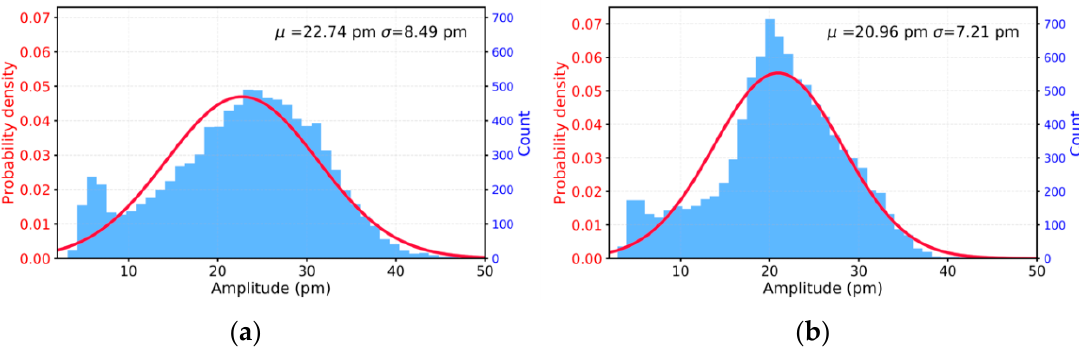
Figure 6. Piezoelectric amplitude histograms of ZnO NW growth on ( a ) ZnO (ALD)/ITO/Si and ( b ) as-printed (not sintered) ZnO seed layer/ITO/PET substrates. The red curve is the Gaussian fitting function.